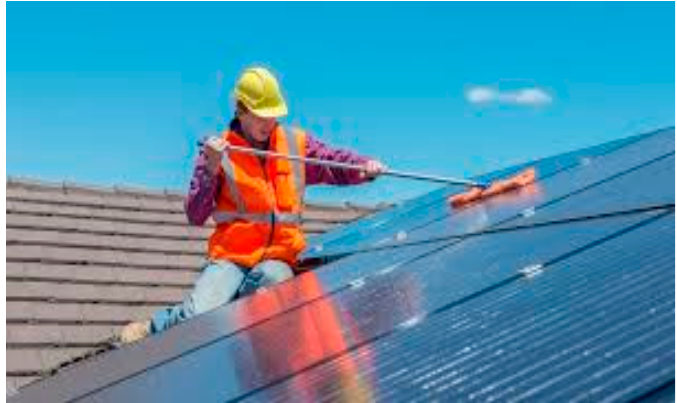
Figure 2. Manual cleaning of solar panels [19].